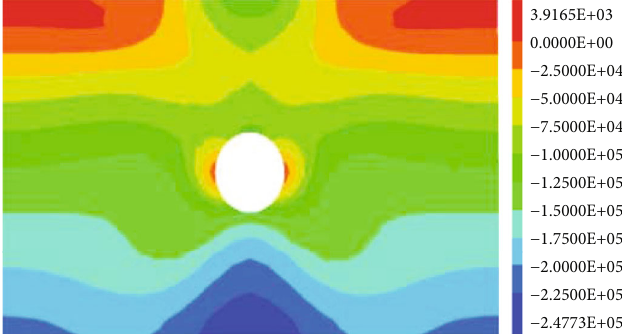
Figure 16: Horizontal stress cloud after